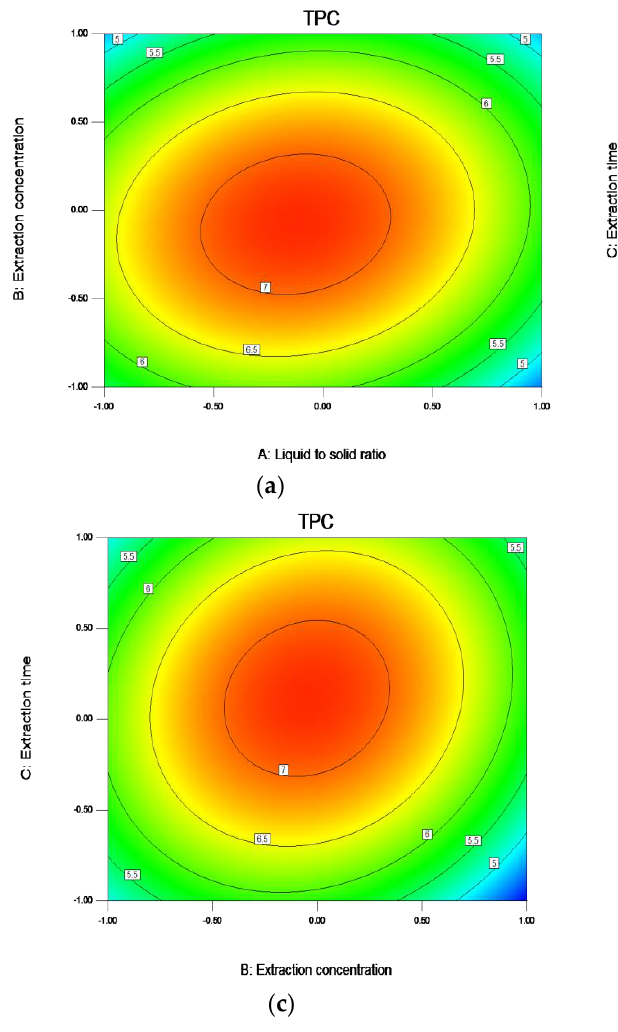
Figure 6. Response contour plots ( a – c ) showing liquid to solid ratio (A), ethanol concentration (B), and extraction time (C) on the extraction yield of TPC. Note: The ratio of liquid to solid (A) − 1.0, 0.5, 0.0, 0.5, and 1.0, respectively, represent 15:1, 17.5:1, 20:1, 22.5:1, and 25:1; The Ethanol concentration (B) −1.0, 0.5, 0.0, 0.5, and 1.00, respectively, represent 70, 72.5, 75, 77.5, and 80; The Extraction time (C) −1.0, 0.5, 0.0, 0.5, and 1.0, respectively, represent 1.5, 1.75, 2, 2.25, and 2.5.